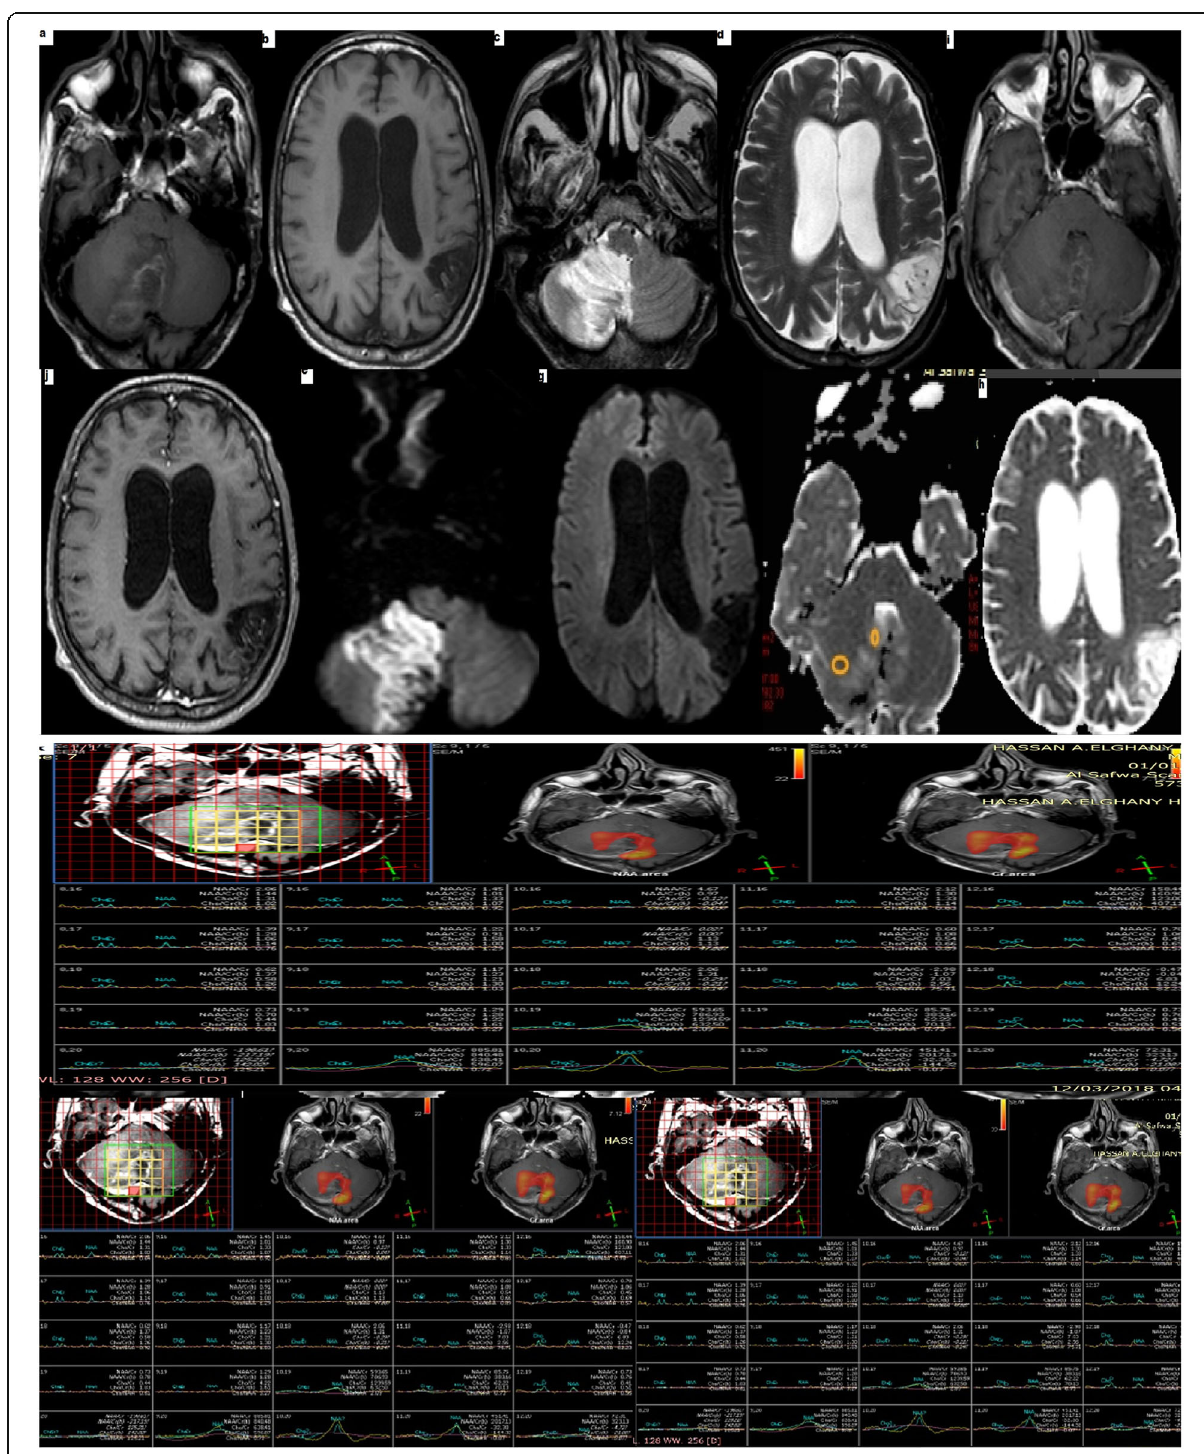
Fig. 4 “ A 42-year-old female patient ” MRI exam revealed multiple well-defined abnormal signal intensity lesions at the cerebellum and Lt. occipital regions that exhibit hypointense signal at T1 with hyperintense foci within cerebellum lesion (suggesting blood) ( a , b ) and hyperintense signals at T2 ( c , d ) with no associated edema. DWI and ADC map ( e , f and g , h ) showed mixed diffusion changes (restriction/T2 shin effect at cerebellum and facilitated diffusion of occipital lesion). Post Gad ( i , j ) showed no contrast appreciable enhancement. MRS ( k ) revealed no significant changes either of NAA, Cr, or Cho peaks with maintained ratios at the lesional and pre-lesional areas. MRI diagnosis: multiple infarcts of different chronologic ages that proved by clinical diagnosis and